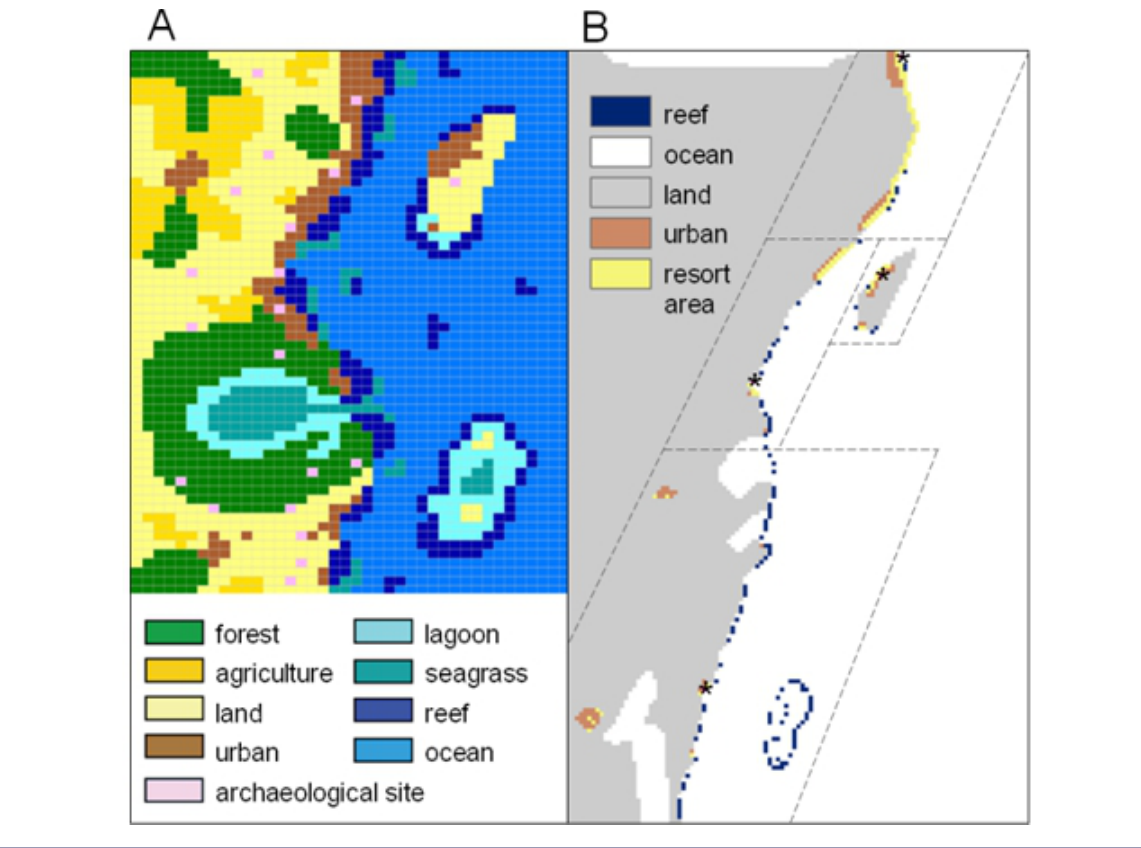
Fig. 2. Gridded base maps for (A) SimReef and (B) the coupled model. The SimReef base map is geographically distorted but includes recognizable features of the Quintana Roo region (e.g., Cozumel to the north and Banco Chinchorro to the south). The base map for the coupled model provides a more realistic spatial representation of the region with the location of coral reef cells extracted from reef distribution maps from the University of South Florida’s Institute for Marine Remote Sensing Millennium Coral Reef Mapping Project (IMaRS 2004). Asterisks in (B) identify the locations of major ports for fishing vessels, and dashed lines delineate the four municipalities used in the coupled model. Cell dimensions are not explicit in the SimReef base map, but each cell corresponds to an area of approximately 25 km 2 . The base map for the coupled model uses a grid of 2 km x 2 km